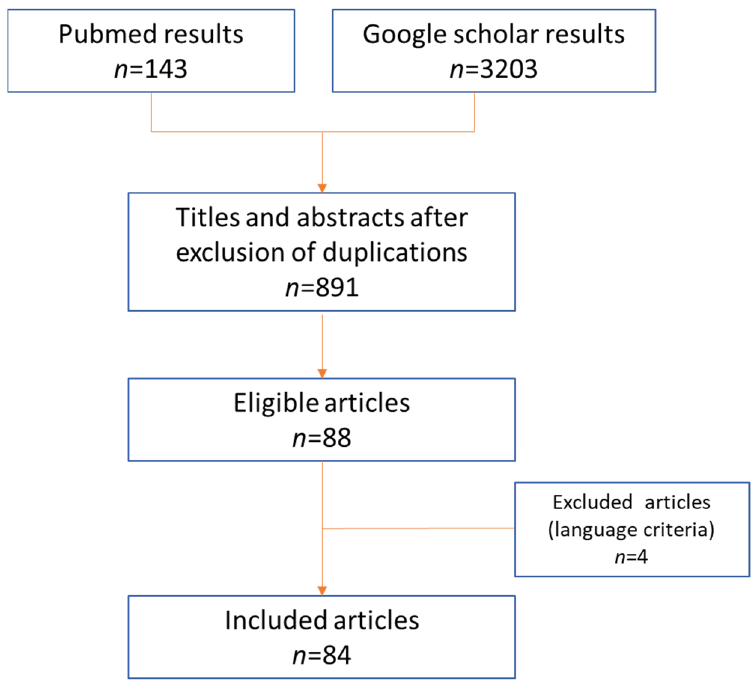
Figure 2. Literature search results according to PRISMA criteria.